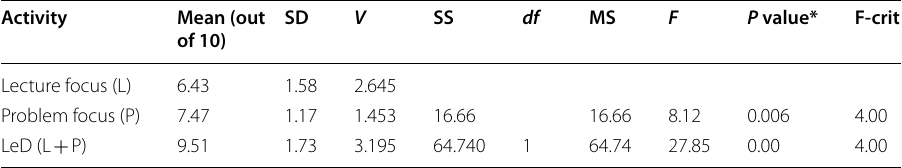
* Significant at p value <